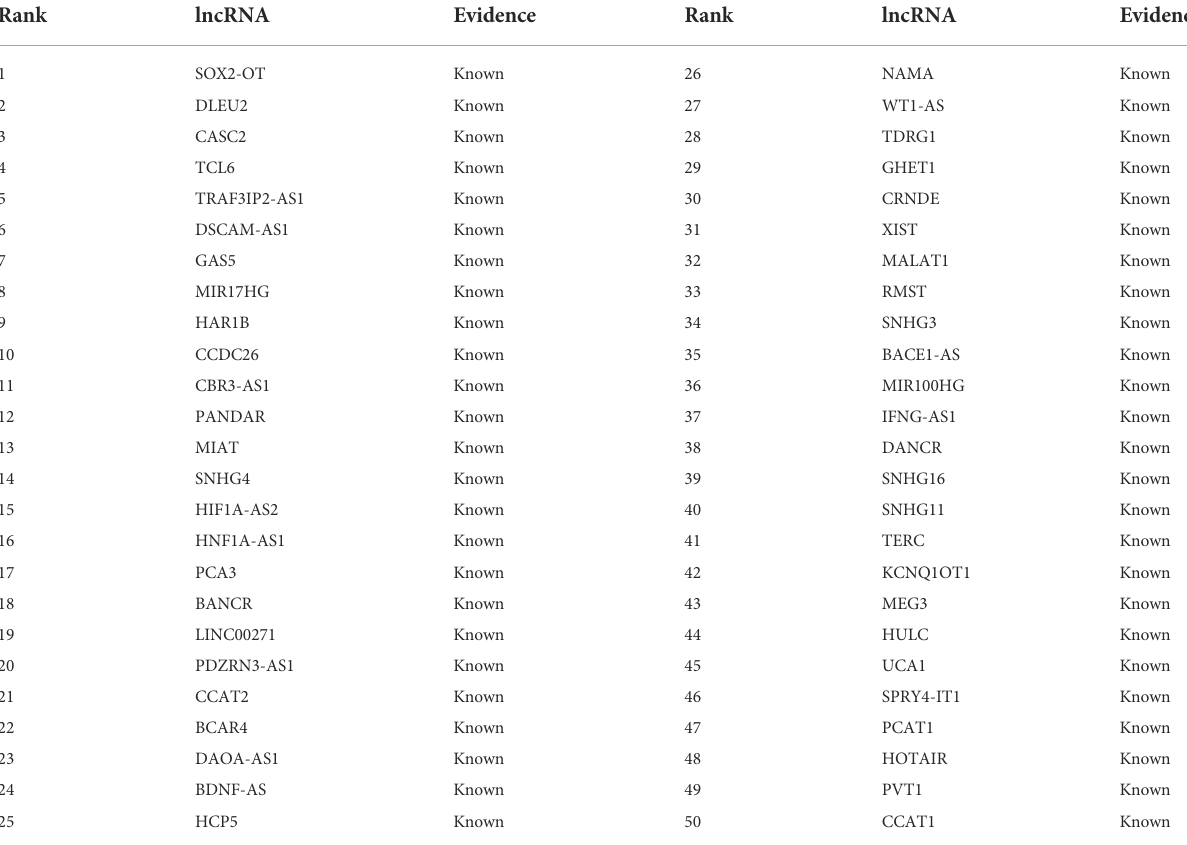
TABLE 4 The rankings of the identi fi ed top 50 lncRNAs associated with colorectal cancer on the MNDR dataset.